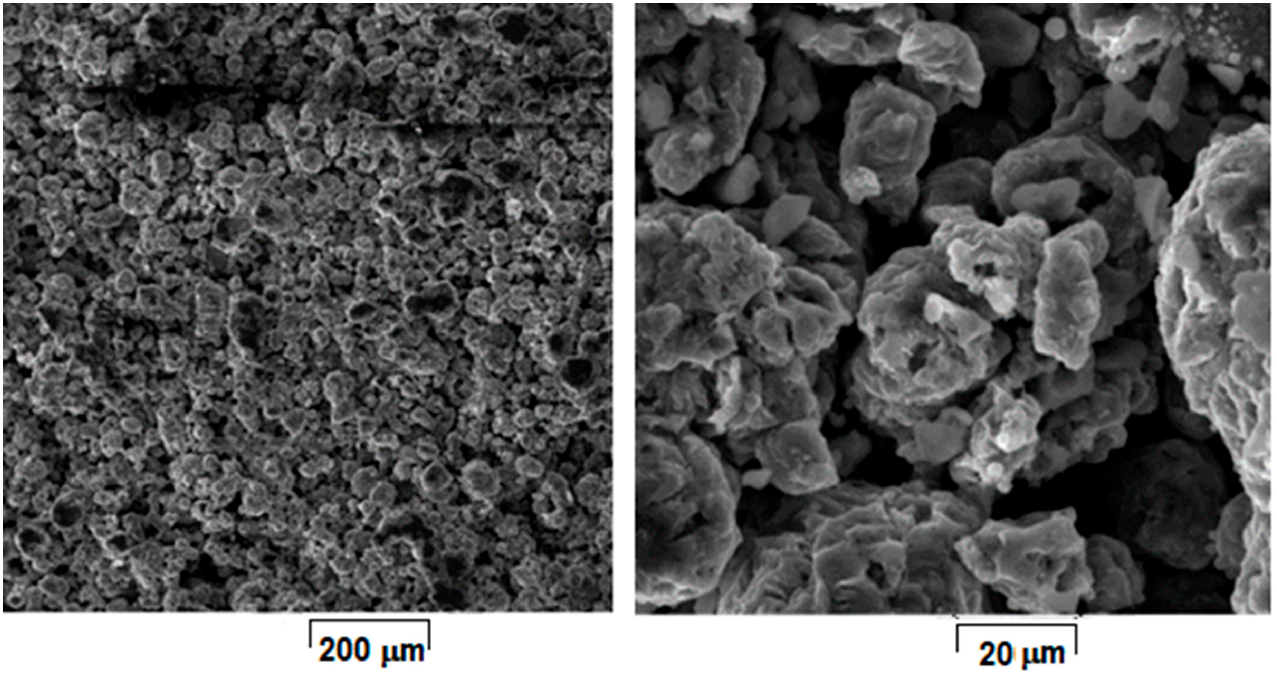
Figure 5. SEM-SE images of L-PBF sample obtained with Laser power 180 W; Scanning speed 1000 mm/s; Layer height 20 μ m applied parameters and calculated Laser energy density 300 J/mm 3 .